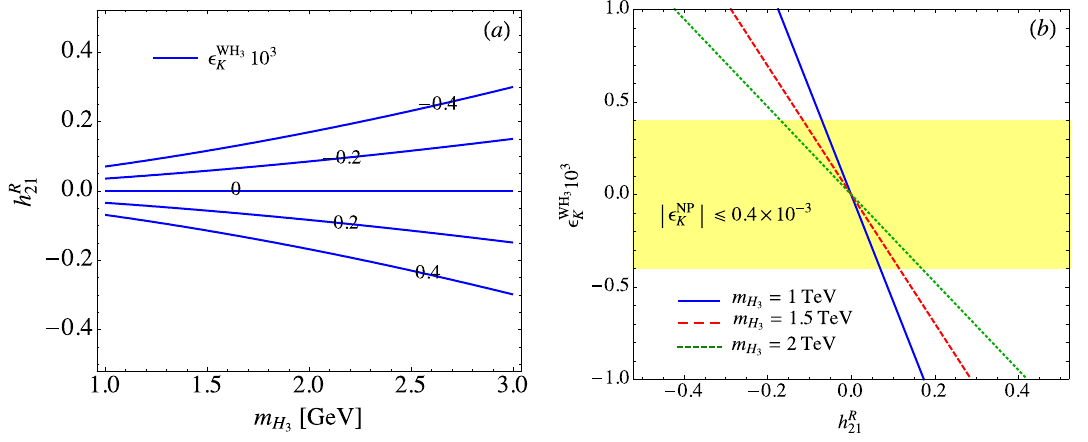
Figure 5 . (a) Contours for (cid:15) WH 3 (in units of 10 (cid:0) 3 ) as a function of m H K a function of h R , where the solid, dashed, and dotted lines represent the contributions of m H 21 (1 ; 1 : 5 ; 2) TeV, respectively. The band denotes the required limit shown in eq. (5.2).